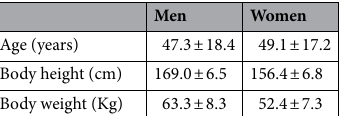
Table 1. The details of the subjects. All values are expressed as mean ± standard deviation.